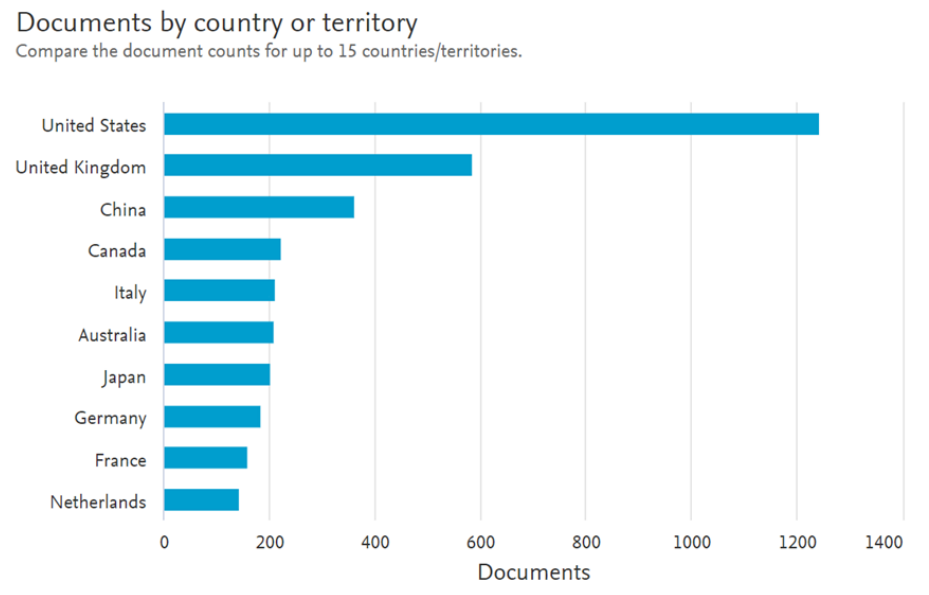
Figure 5. Interest in Considering OB by